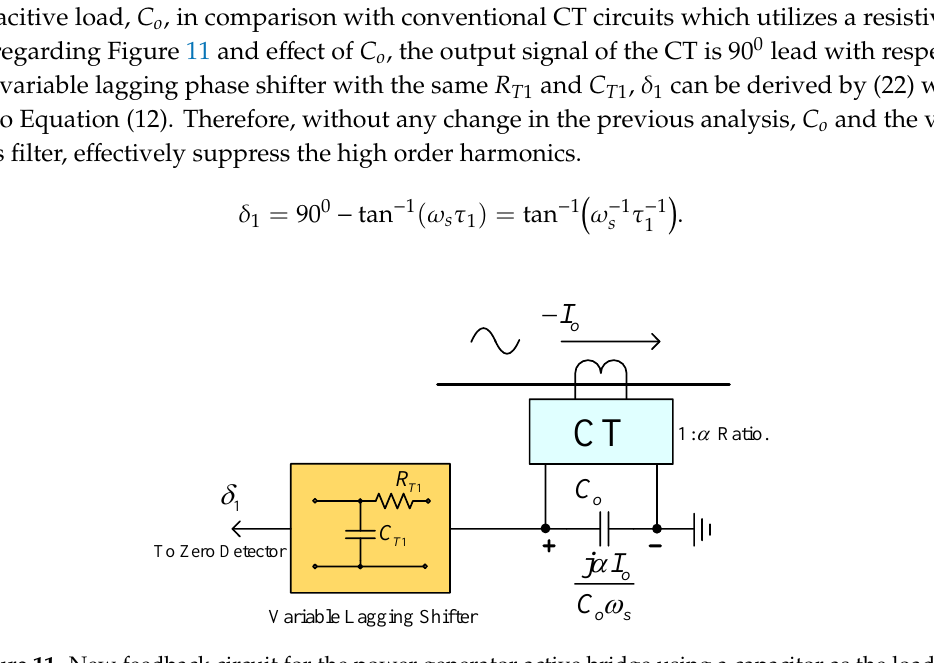
Figure 10. Output voltage of charger bridge, EV bridge and i o under equal voltages condition with τ 1 = 10µs and τ 2 = 1µs while the power is in backward direction.